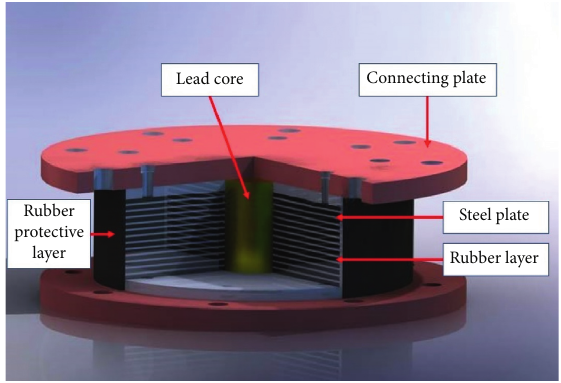
Figure 2: Schematic diagram of GZY isolation bearing.